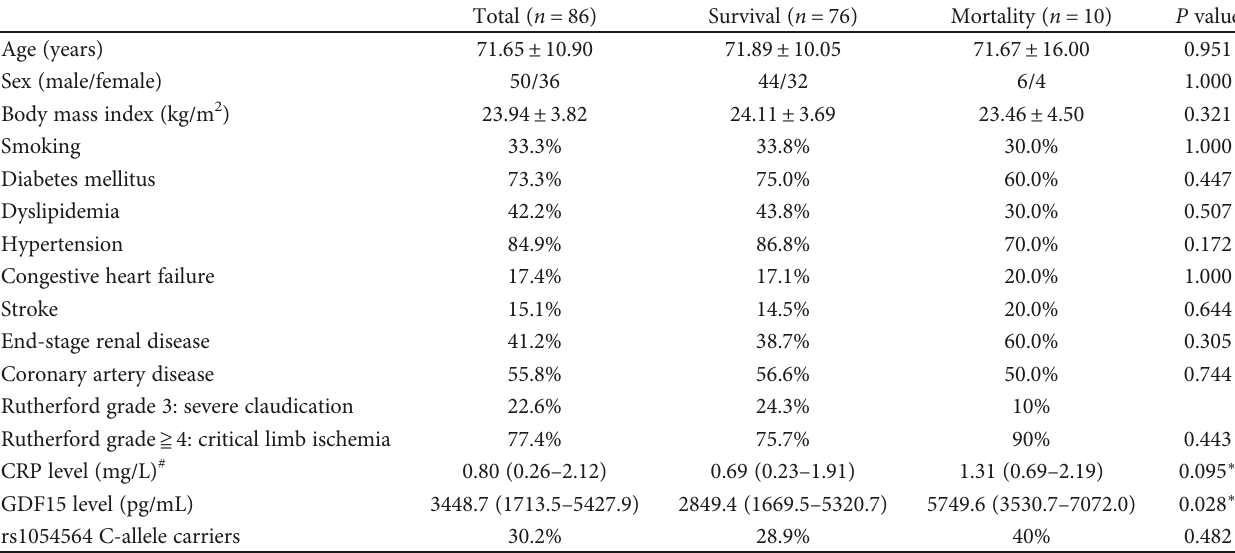
Table 6: Demographics of peripheral artery disease patients with or without